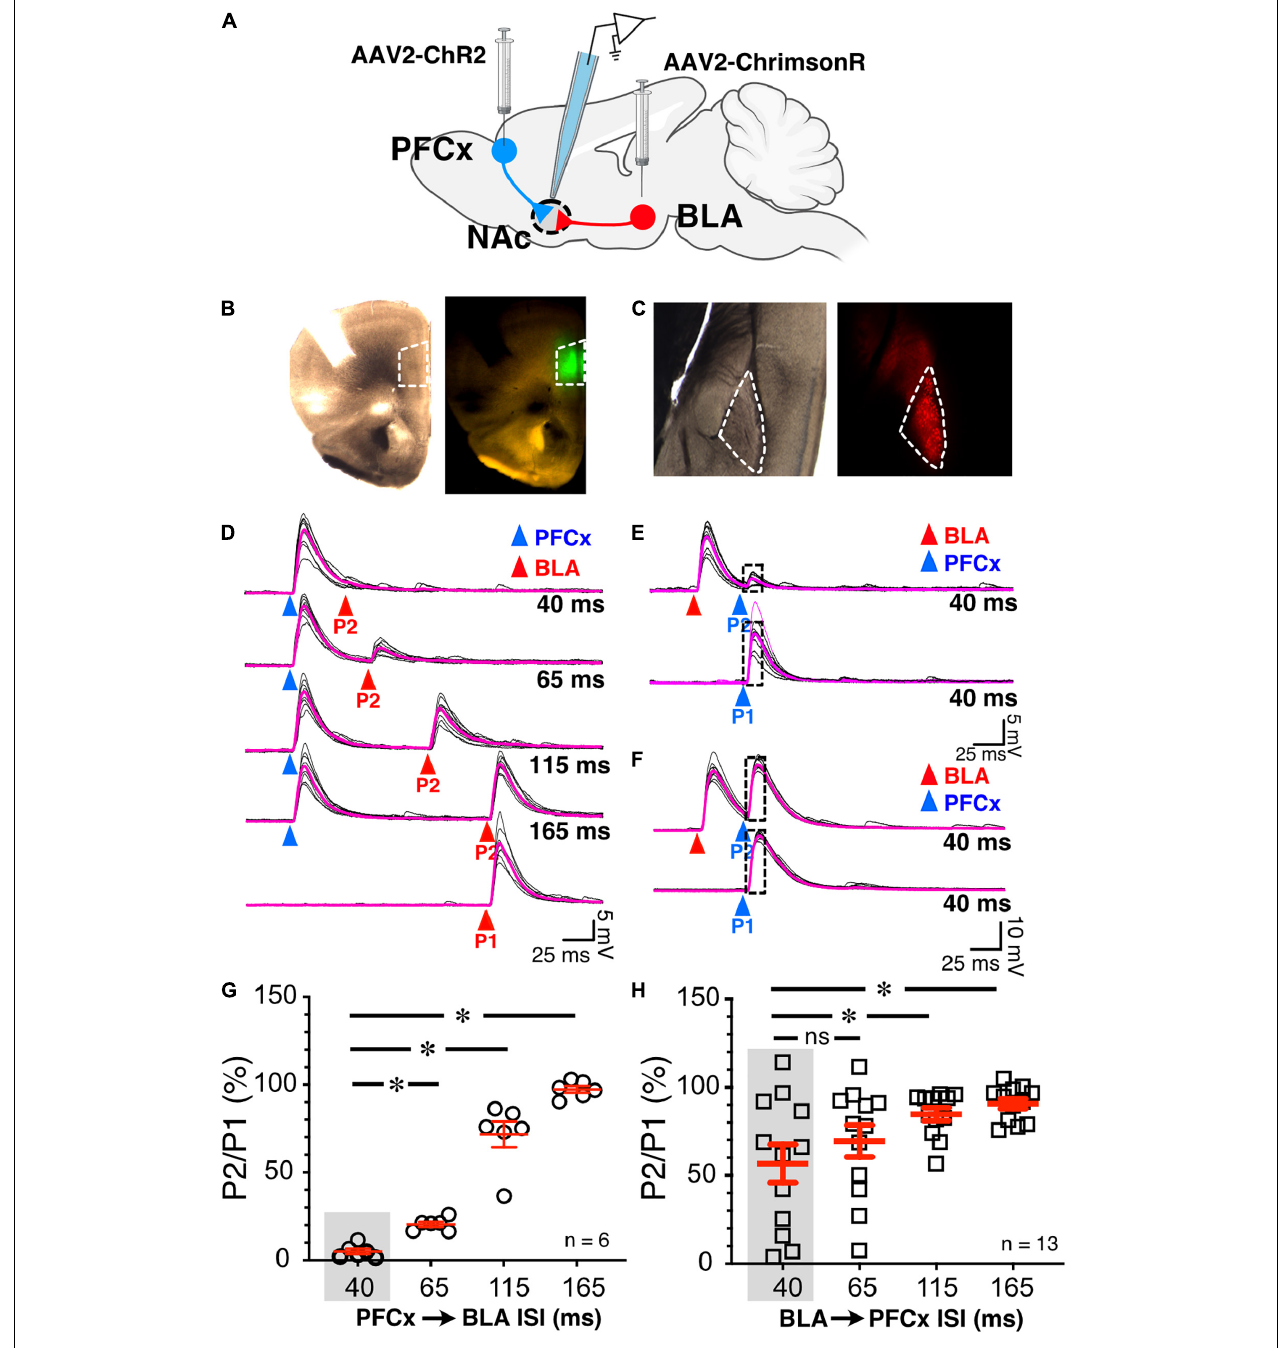
FIGURE 2 | Synaptic gating between BLA and PFCx inputs is bidirectional and asymmetric in alcohol-naïve mice in NAc MSNs. (A) Cartoon illustrating the injections and the recording sites. (B) Bright field (left panel) and epifluorescence of AAV2-ChR2-eYFP injected in the prelimbic prefrontal cortex area outlined by white broken line. (C) Bright field (left panel) and epifluorescence of AAV2-ChrimsonR-tdTomato injected in the amygdala area outlined by white broken line. Note that the infection is confined to the targeted areas. (D) 10 overlaid traces of PFCx-EPSPs (blue arrowheads) evoked before stimulation of the BLA pathway (red arrowheads, P2) at increasing interstimulus intervals (from 40 to 165 ms, ISI). As a control, the lowest traces (red P1) show BLA-EPSPs evoked in the absence of PFCx-EPSPs. (E,F) 10 overlaid traces of BLA- EPSPs (red arrowheads) evoked before PFCx-EPSPs (blue arrowheads, P2) at a 40 ms interval. While BLA-EPSPs inhibit PFCx-EPSPs in some MSNs (B) at this short interval, it fails to do so in others (C) . (G) Circles show the magnitude of the gating of BLA-EPSPs (P2) by PFCx inputs (PFCx → BLA) at various intervals expressed as percent relative to control (P1) in 6 MSNs. (H) Square symbols show magnitude of the gating of PFCx-EPSPs (P2) by BLA inputs (BLA → PFCx) at various intervals relative to control (P1) in 13 MSNs. Each symbol presents a MSN. Average values in graphs are expressed as mean ± standard error (SEM). ∗ p < 0.01. Purple traces show averaged EPSPs in panels (D–F)